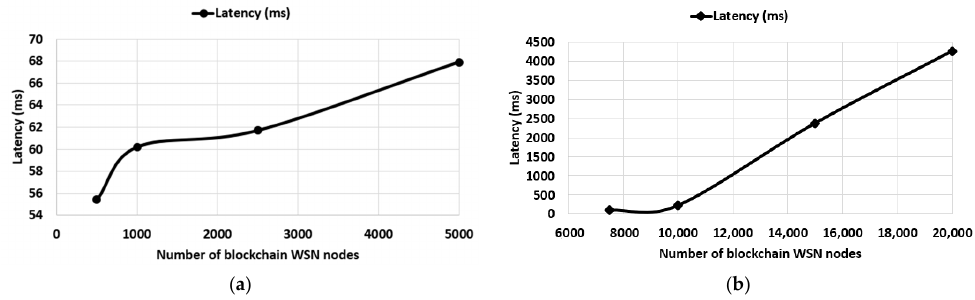
Figure 4. Average latency metric for the proposed blockchain architecture: ( a ) 500, 1000, 2500, 5000 blockchain WSN nodes; ( b ) 7500, 10,000, 15,000, 20,000 blockchain WSN nodes. Figure 5a,b show the transaction throughput, which is the number of transactions that a blockchain architecture can process. In our case, transactions are the data packets sent by the blockchain WSN nodes. In our testing, we have approximately 496.31 TPS for a total of 500 blockchain WSN nodes, and 16,006.73 transactions for a total of 20,000 block- chain WSN nodes.